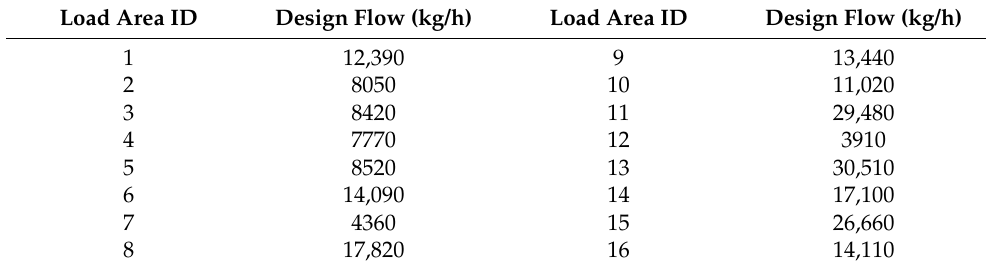
Table 1. The design flow of each block.